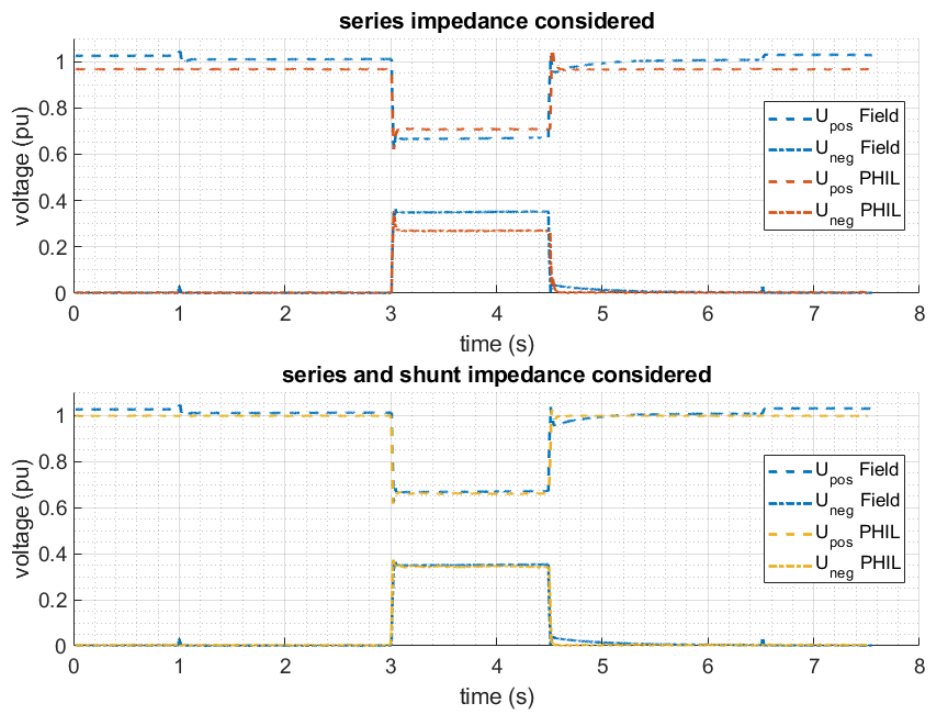
Figure 9. Comparison of the positive and negative sequence voltages between a field and a grid emulator measurement using the PHiL setup.